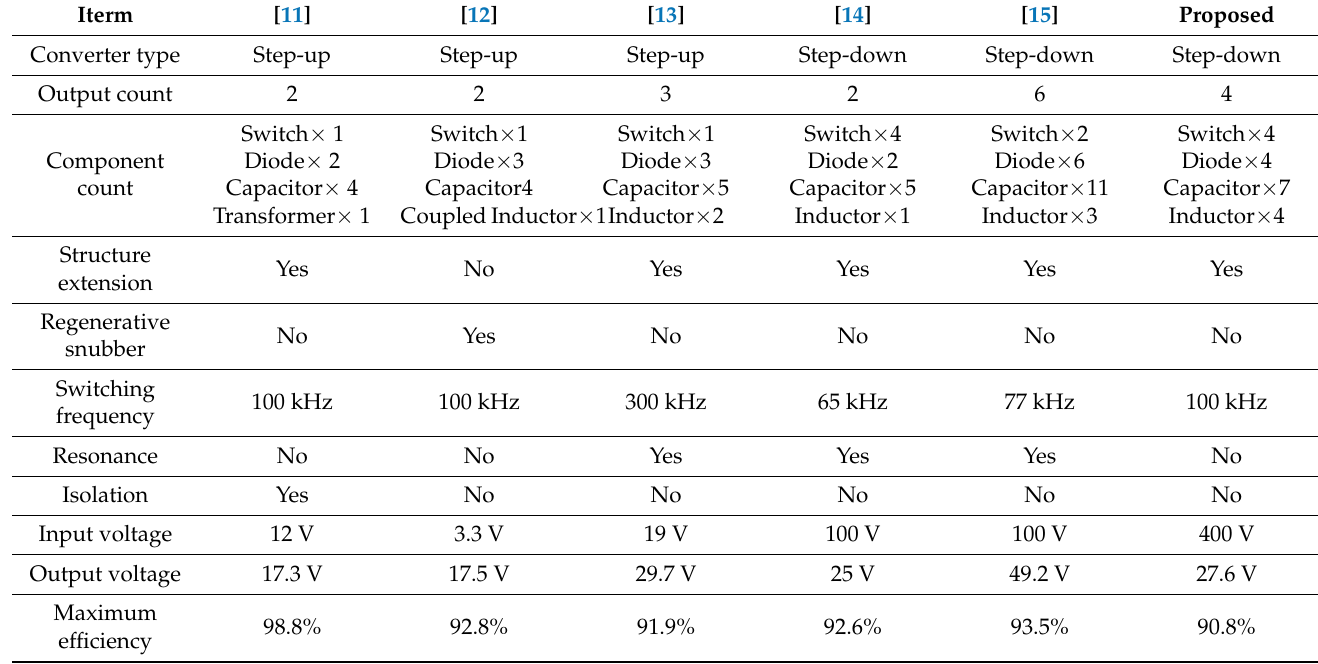
Table 6. Circuit comparison between the existing [11–15] and the